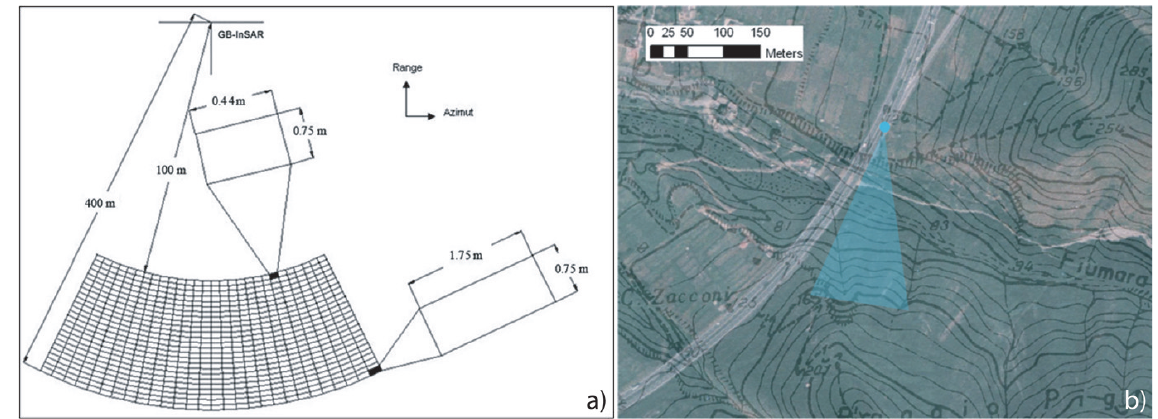
Fig. 5. (a) Resolution grid size used during the monitoring campaign of Santa Trada landslide. (b) Localization of the Santa Trada landslide nearby the A3 motorway and the Fiumara di Santa Trada. The blue area roughly represents the radar field of